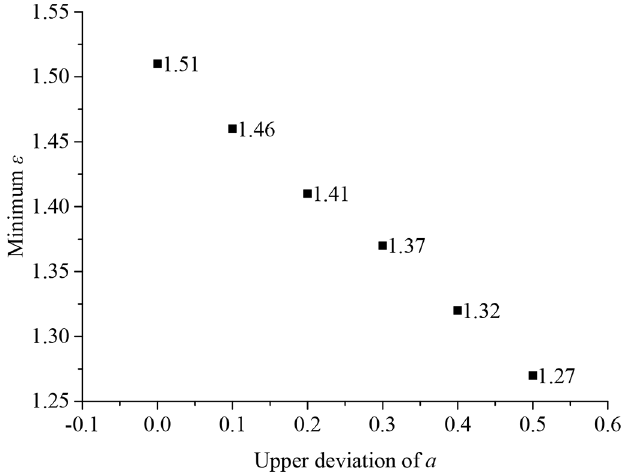
Fig. 6. Relation between the upper deviation of a and the minimum e .